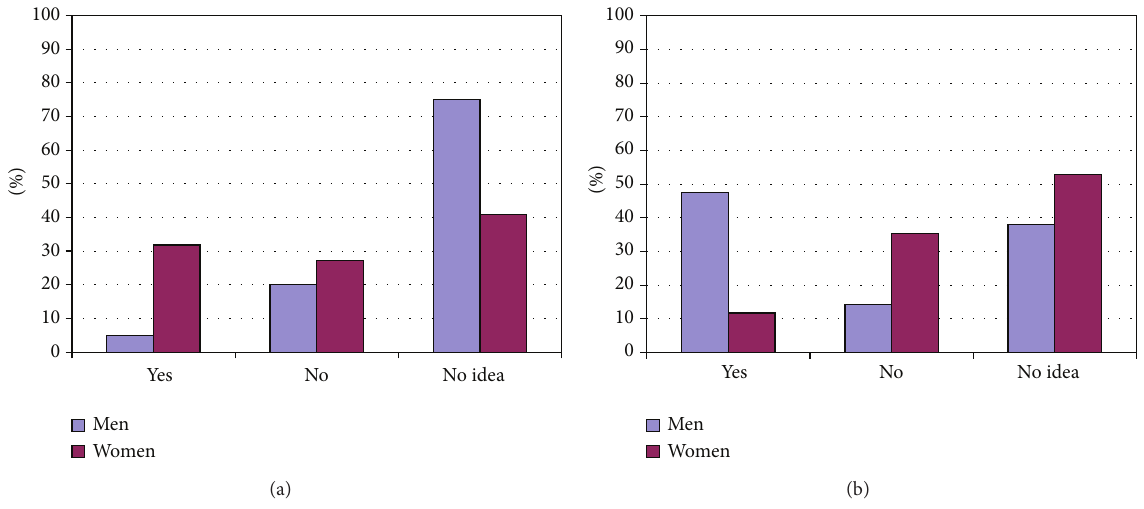
Figure 12: Changes to privacy settings on Instagram. DN (a) and DI